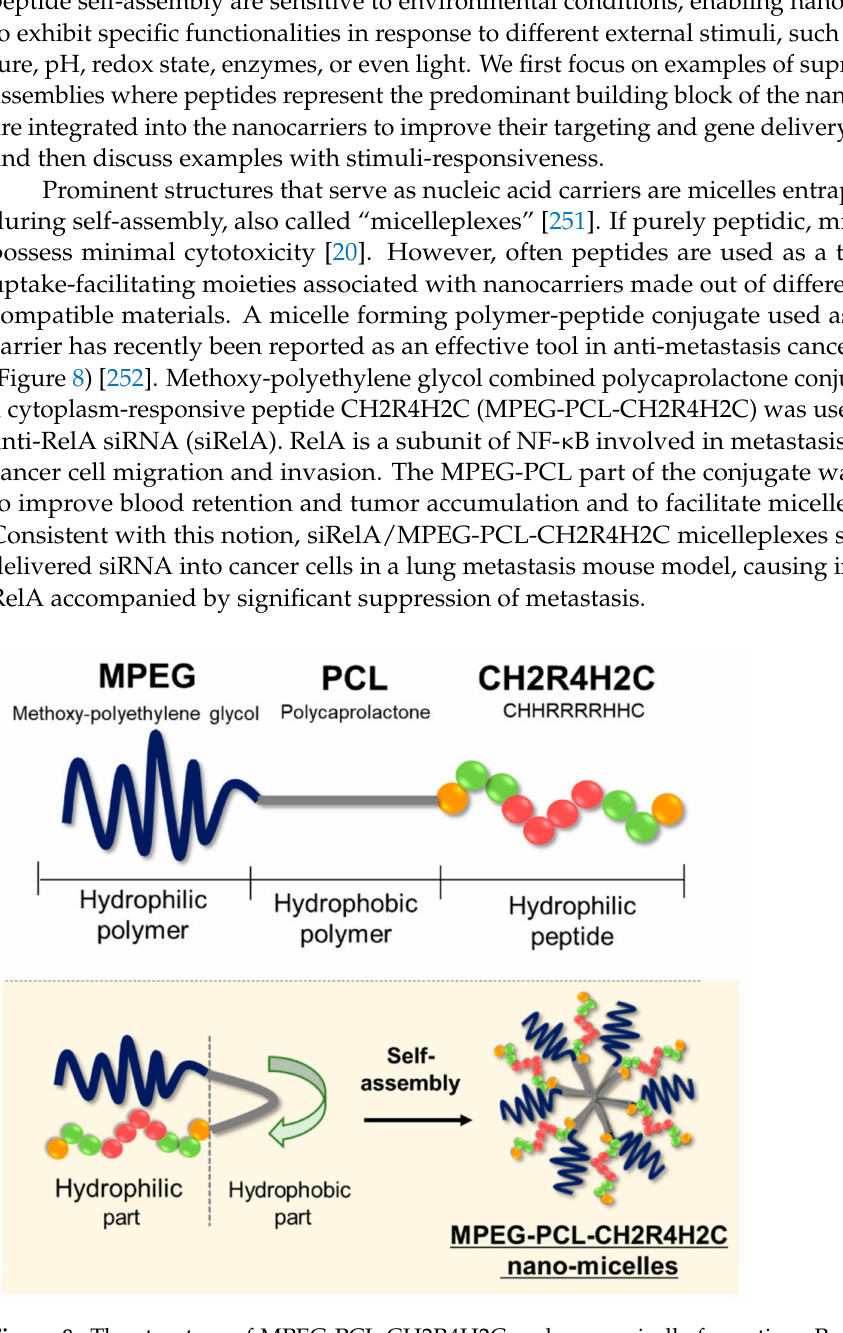
Figure 8. The structure of MPEG-PCL-CH2R4H2C and nano-micelle formation. Reprinted with permission from [252]. Copyright 2020 Multidisciplinary Digital Publishing Institute